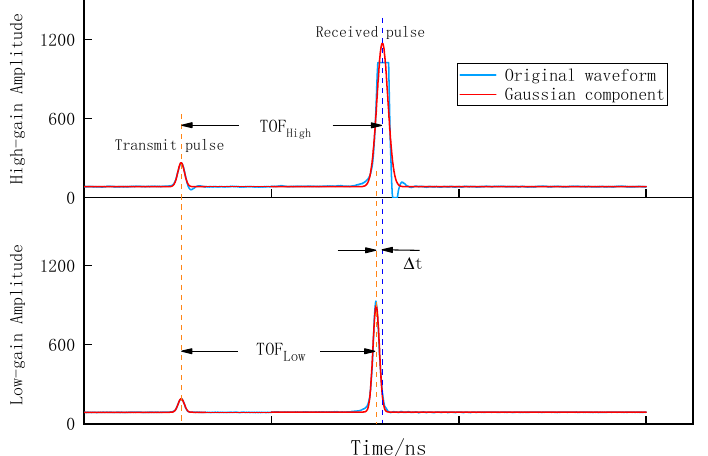
Figure 6. Schematic diagram of the deviation of the Gaussian fitting results in high gain (saturated) and low gain (unsaturated). TOF is the pulse flight time and Δ t is the ranging difference.